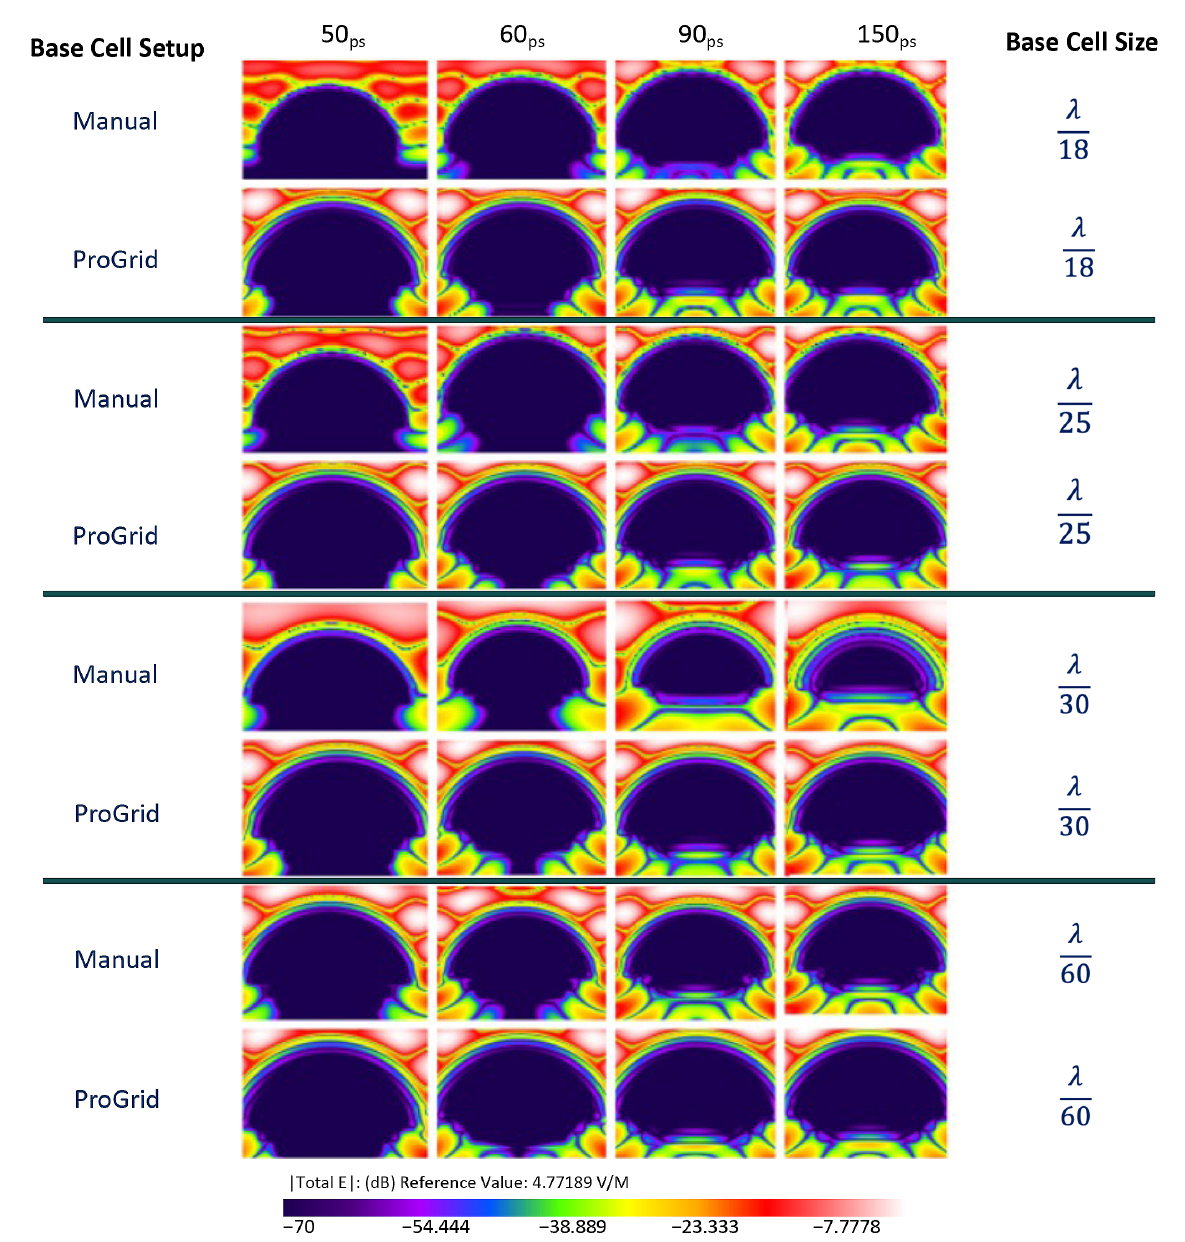
Figure 5. The output of planar E-field sensors for an EM source of 60GHz; the location of a planar E-field sensor placed vertically within the cornea. The simulation was carried out for λ /18 and λ /25, λ /30, and λ /60 using manual and PrOGrid